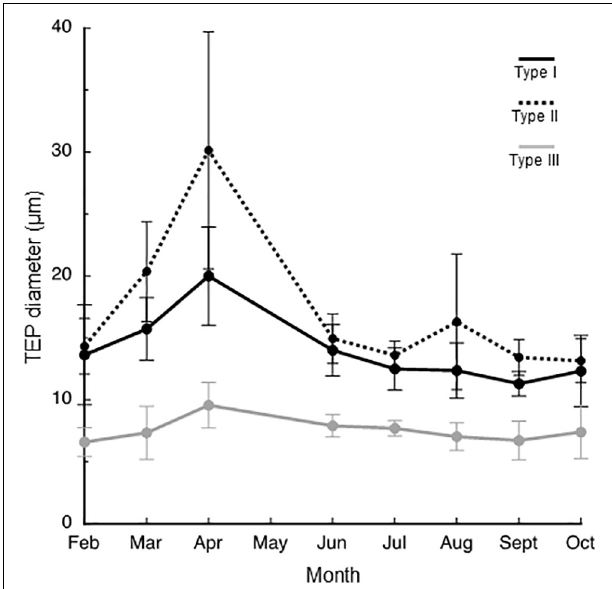
FIGURE 4 | Seasonal changes in the diameter of transparent exopolymer particle (TEP) types. Means of the data collected at different depths are presented with errors (standard deviations, n = 7).